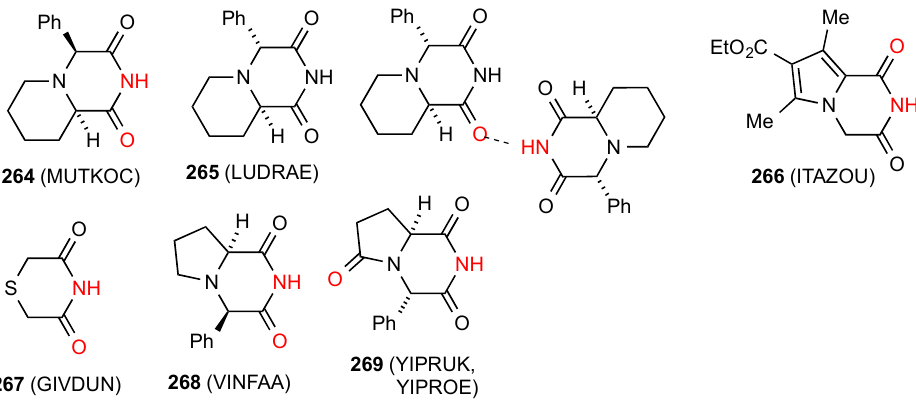
Figure 75. Six-membered ring imides with more than one heteroatom showing patterns A , B and F.